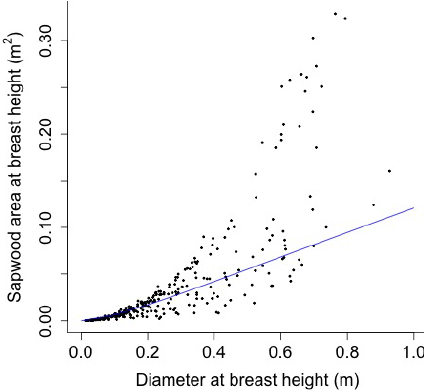
Figure D17. Sapwood area at breast height model fit to BAAD for Robinia .